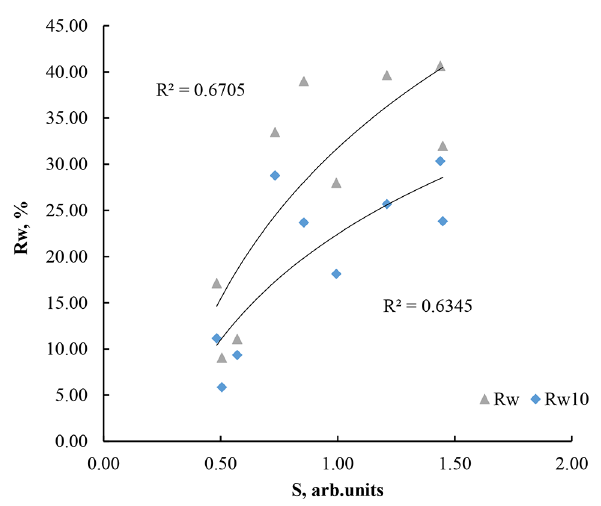
Fig. 10 Relation between damage indices of coals and graphite on the share of amorphous carbon with respect to crystallite